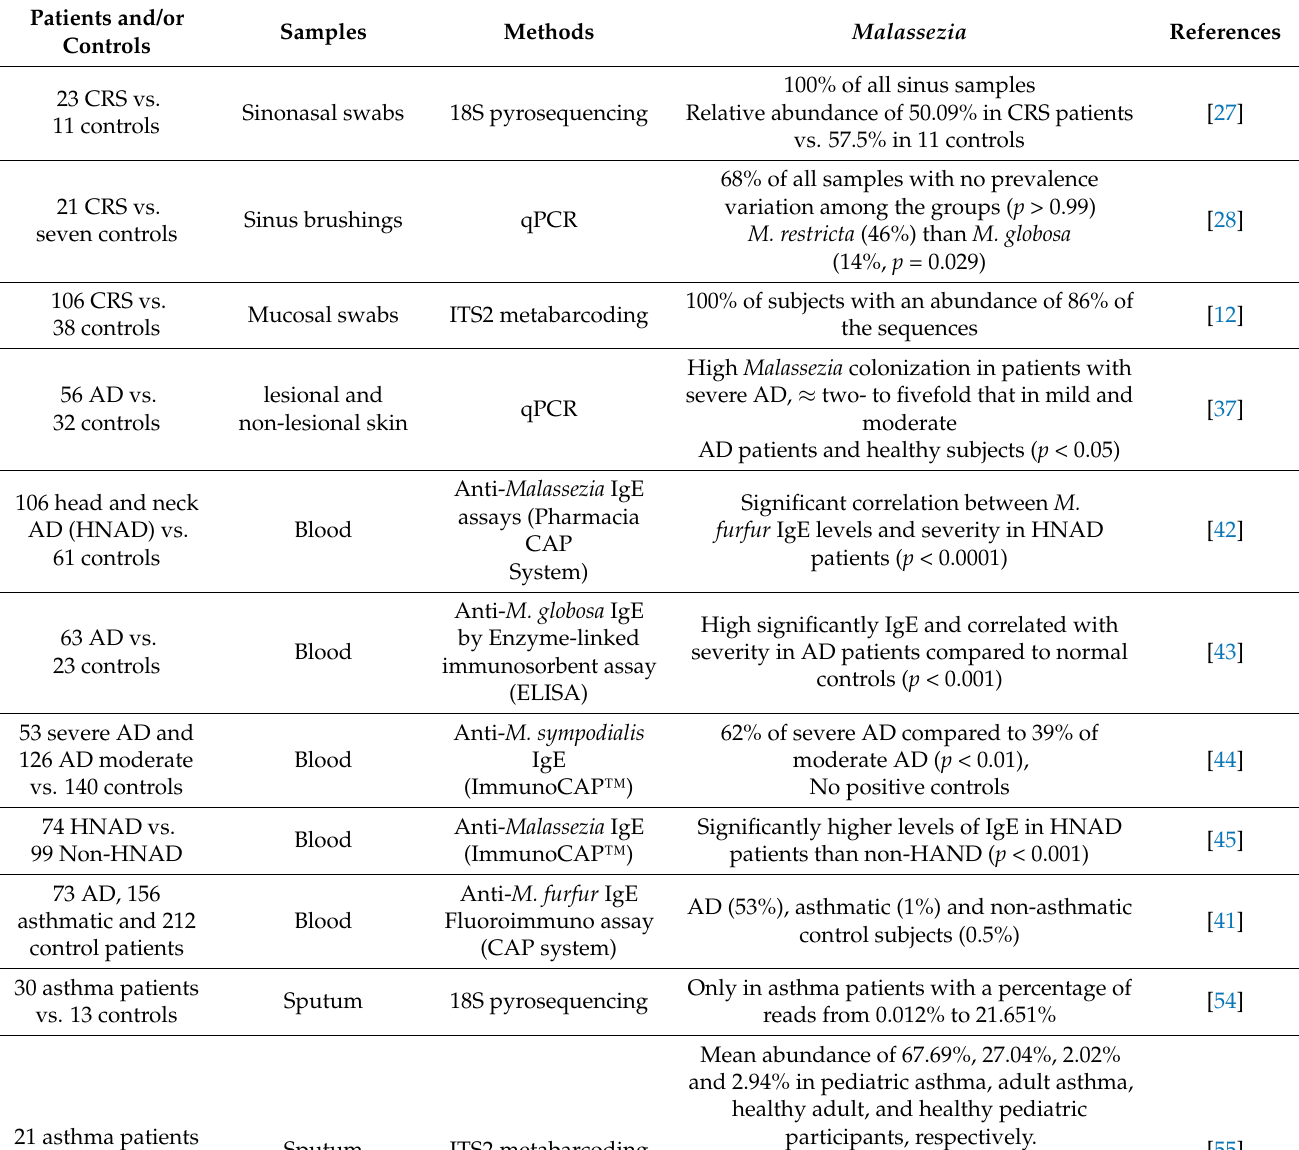
Table 3. Studies associating Malassezia with allergic